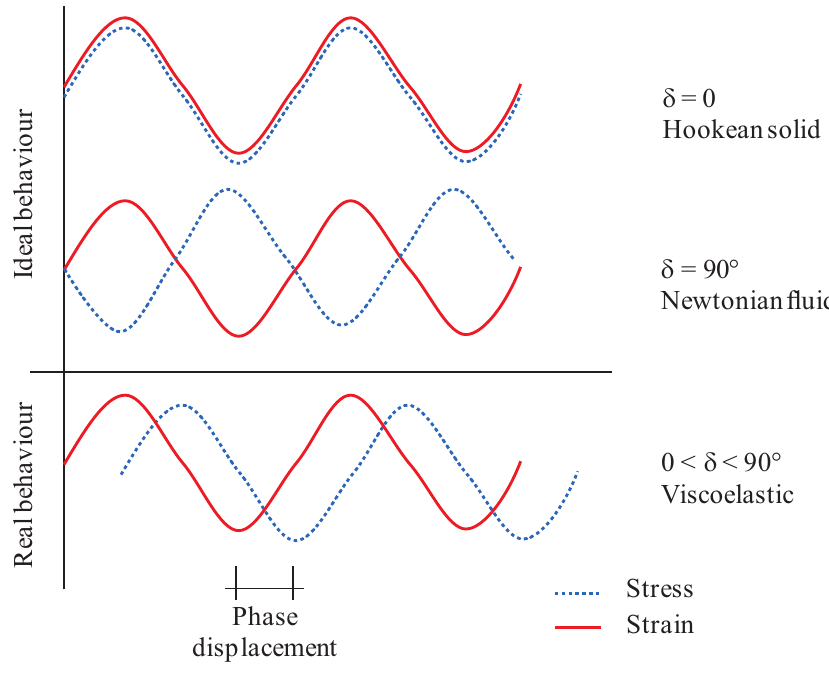
StrainStress Phase Figure 2 Illustration of oscillatory test, applying a sinusoidal strain, obtaining the stress as a response, when the material is ideal (Hookean solid or Newtonian fluid) and real (viscoelastic)